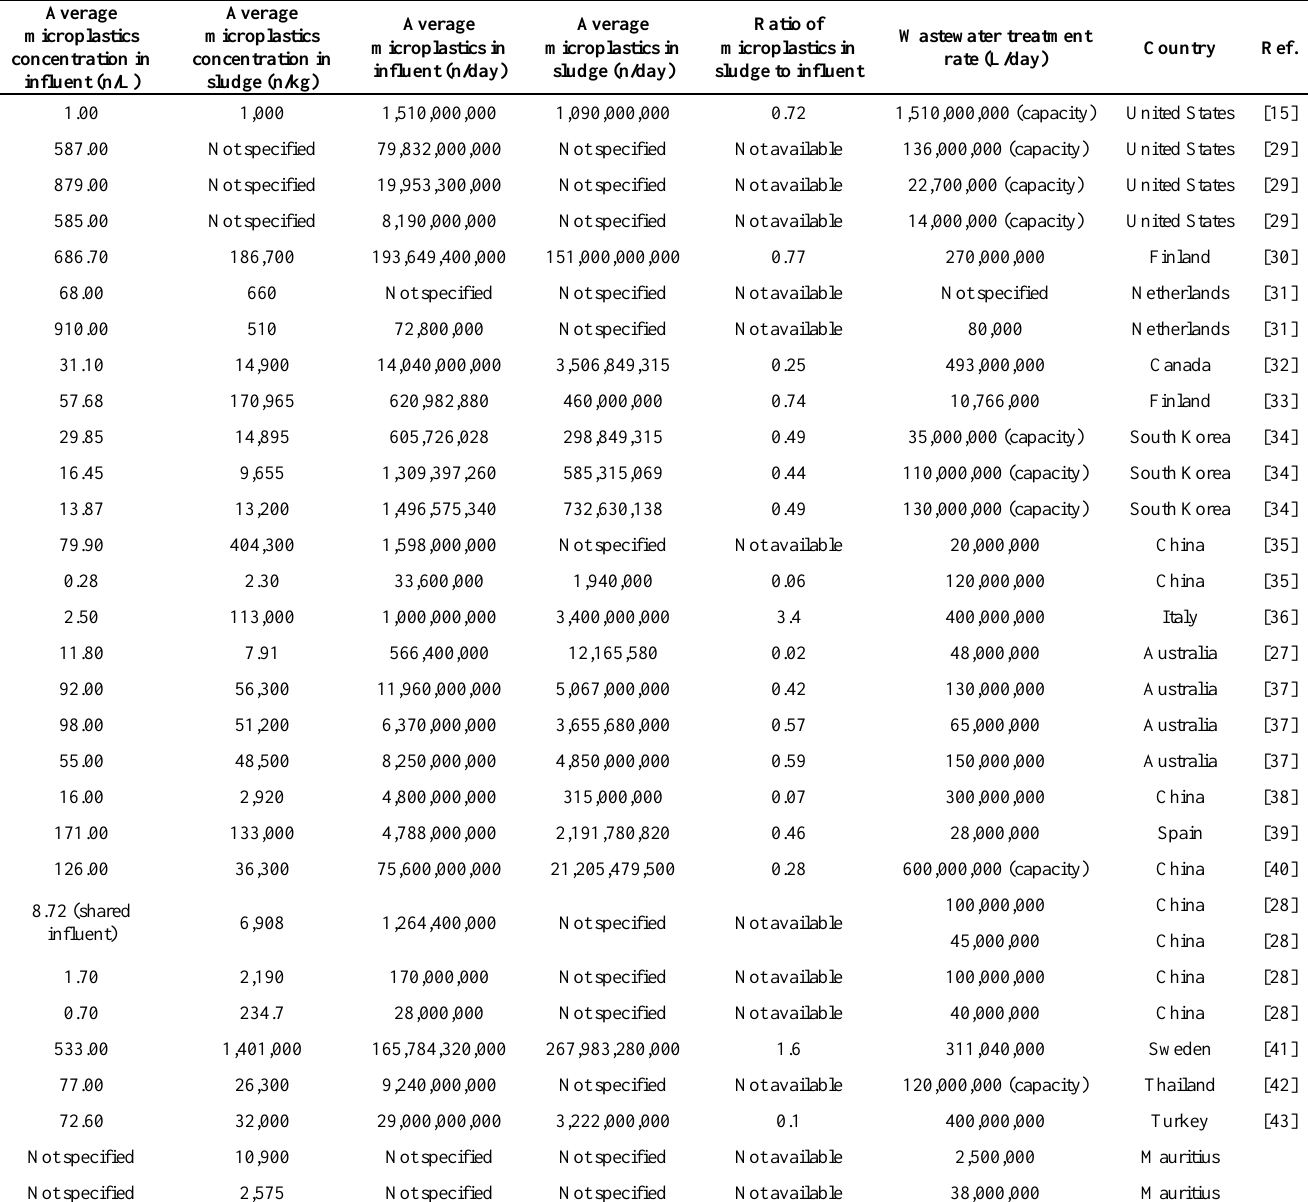
Table 1. The abundance of microplastics in the influents and sludge of WWTPs in different